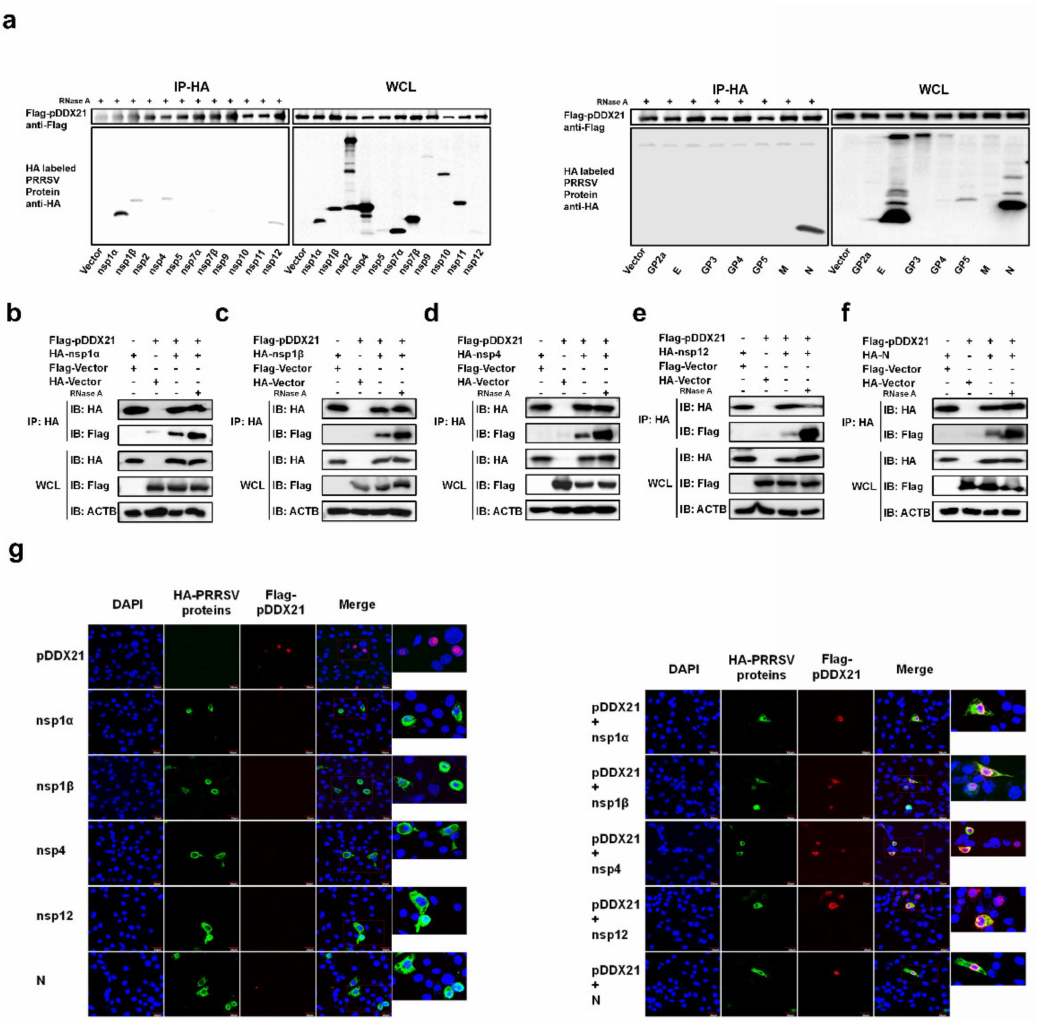
Figure 4. Screening PRRSV proteins for their potential interaction with pDDX21. ( a ) HEK-293T cells were co-transfected with pCAGGS-Flag-pDDX21 (3 µ g) and HA-tagged PRRSV protein expression plasmids (3 µ g). At 30 h post-transfection, the cells were lysed and immunoprecipitated with an anti-Flag monoclonal antibody. Whole-cell lysate (WCL) and IP complexes were analyzed by im- munoblotting with antibodies against Flag, HA, or β -actin. ( b – f ) HEK-293T cells were co-transfected with pCAGGS-Flag-pDDX21 (3 µ g) and HA-tagged nsp1 α ( b ), nsp1 β ( c ), nsp4 ( d ), nsp12 ( e ), or N protein ( f ) expression plasmids (3 µ g). The cells were lysed at 30 h post-transfection and im- munoprecipitated with an anti-HA monoclonal antibody. WCL and IP complexes were analyzed by immunoblotting with antibodies against Flag, HA, or β -actin. ( g ) iPAM cells were co-transfected with pCAGGS-Flag-pDDX21 (1 µ g) and HA-tagged nsp1 α , 1 β , nsp4, nsp12, or N protein expression plas- mids (1 µ g). At 30 h post-transfection, the cells were fixed for an immunofluorescence assay analysis of pDDX21 and nsp1 α , nsp1 β , nsp4, nsp12, or N protein using primary antibodies (mouse anti-Flag and rabbit anti-HA), followed by secondary antibodies (AF594-conjugated donkey anti-rabbit and AF488-conjugated donkey anti-mouse). Nuclei were counterstained with DAPI. Fluorescent images were acquired with a confocal laser scanning microscope (Fluoviewver.3.1; Olympus,